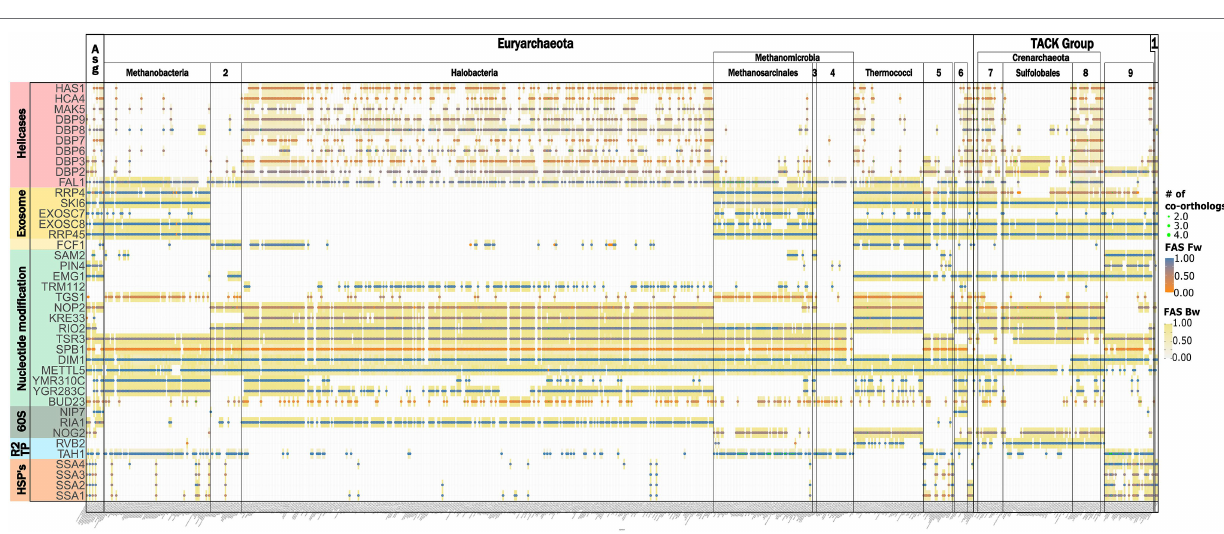
FIGURE 7 | The differential presence-absence pattern of eukaryotic RBFs in the archaeal domain summarized on the class-level. 1: DPANN, 2: Methanococci, 3: Methanocellales, 4: Methanomicrobiales, 5: Thermoproteales, 6: Archaeoglobi, 7: Thermoproteii, 8: Desulfurococcales, and 9